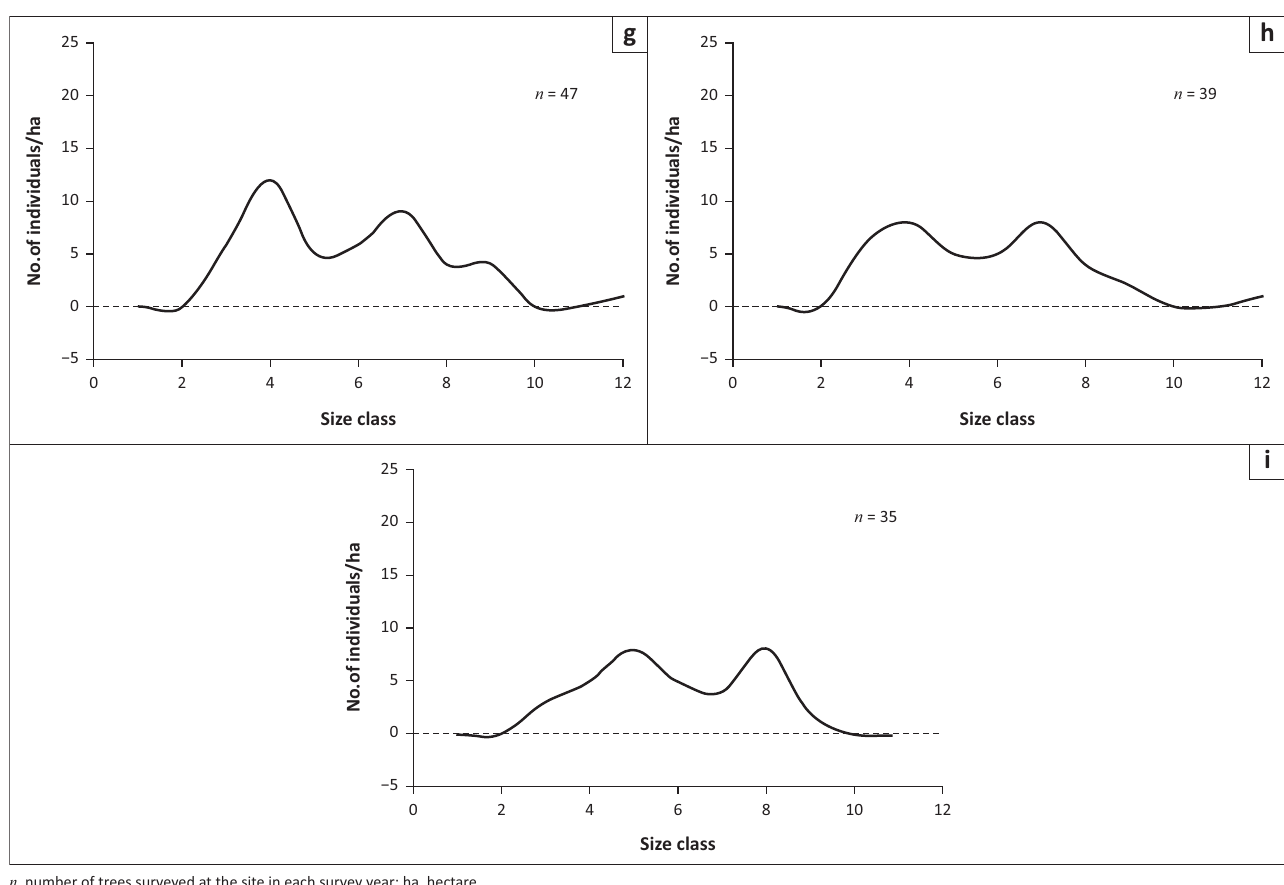
FIGURE 5 (Continues...): Size class distribution curves of Vachellia erioloba individuals at the Grootkolk site in the various survey years. (a) 1986; (b) 1984; (c) 1986; (d) 1989; (e) 1994; (f) 1996; (g) 1999; (g) 2008; (i) TABLE 2: Age calculations, derived by different methods, for Vachellia erioloba trees at the Grootkolk site in the Nossob riverbed using mean stem diameter of the circumference class for the largest live tree; and for circumference size classes that recorded the majority of the dead trees. Method